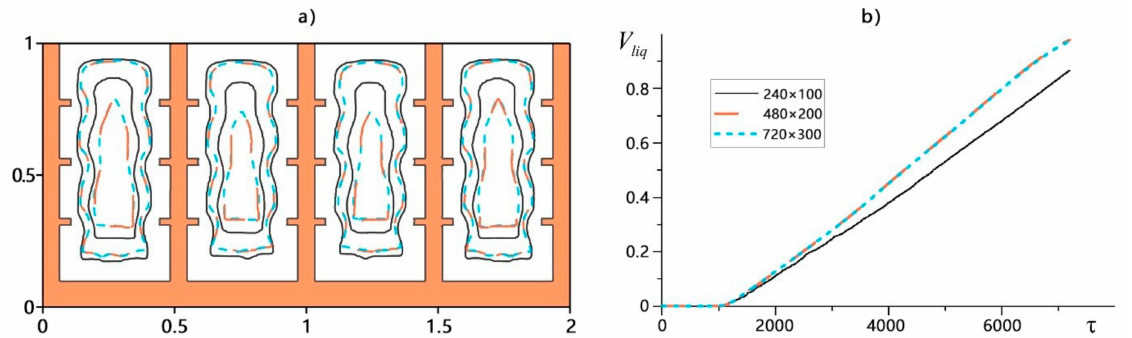
Figure 2. The grid independence test: the phase front location at t = 25 and t = 35 min ( a ), as well as a graph of the dependence of the volume fraction of the melt on the dimensionless time ( b